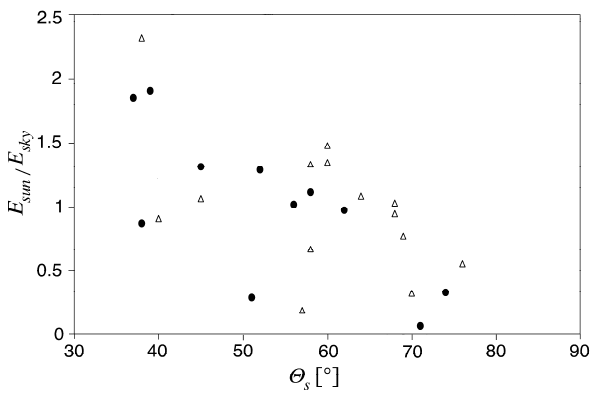
Fig. 6. The ratio E sun / E sky as a function of the solar zenith angle θ s . The filled circles and open triangles represent 405 and 650nm, respectively. The ratios are normalized against their mean values at these wavelengths.